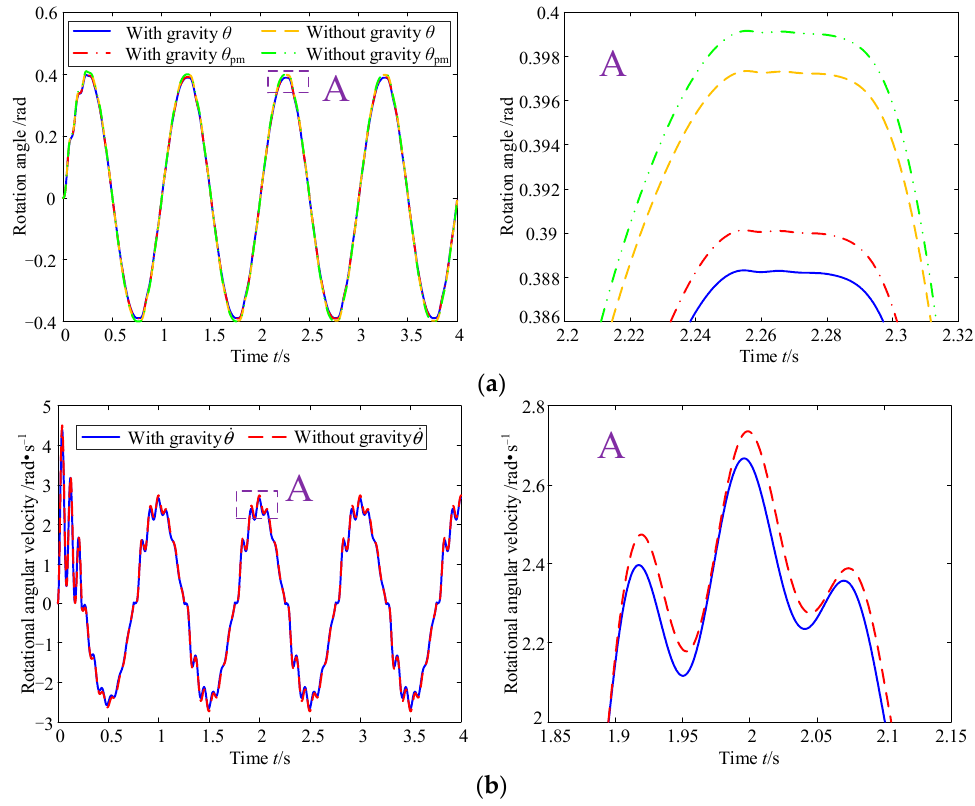
Figure 3. Effect of gravity on the dynamic performance of the variable stiffness actuator system at constant stiffness: ( a ) rotation angle and ( b ) rotational angular velocity.